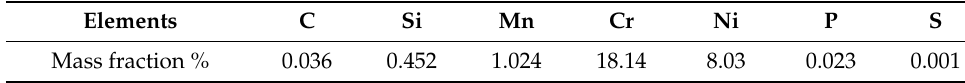
Table 1. Chemical composition of 304 austenitic stainless steel. Elements C